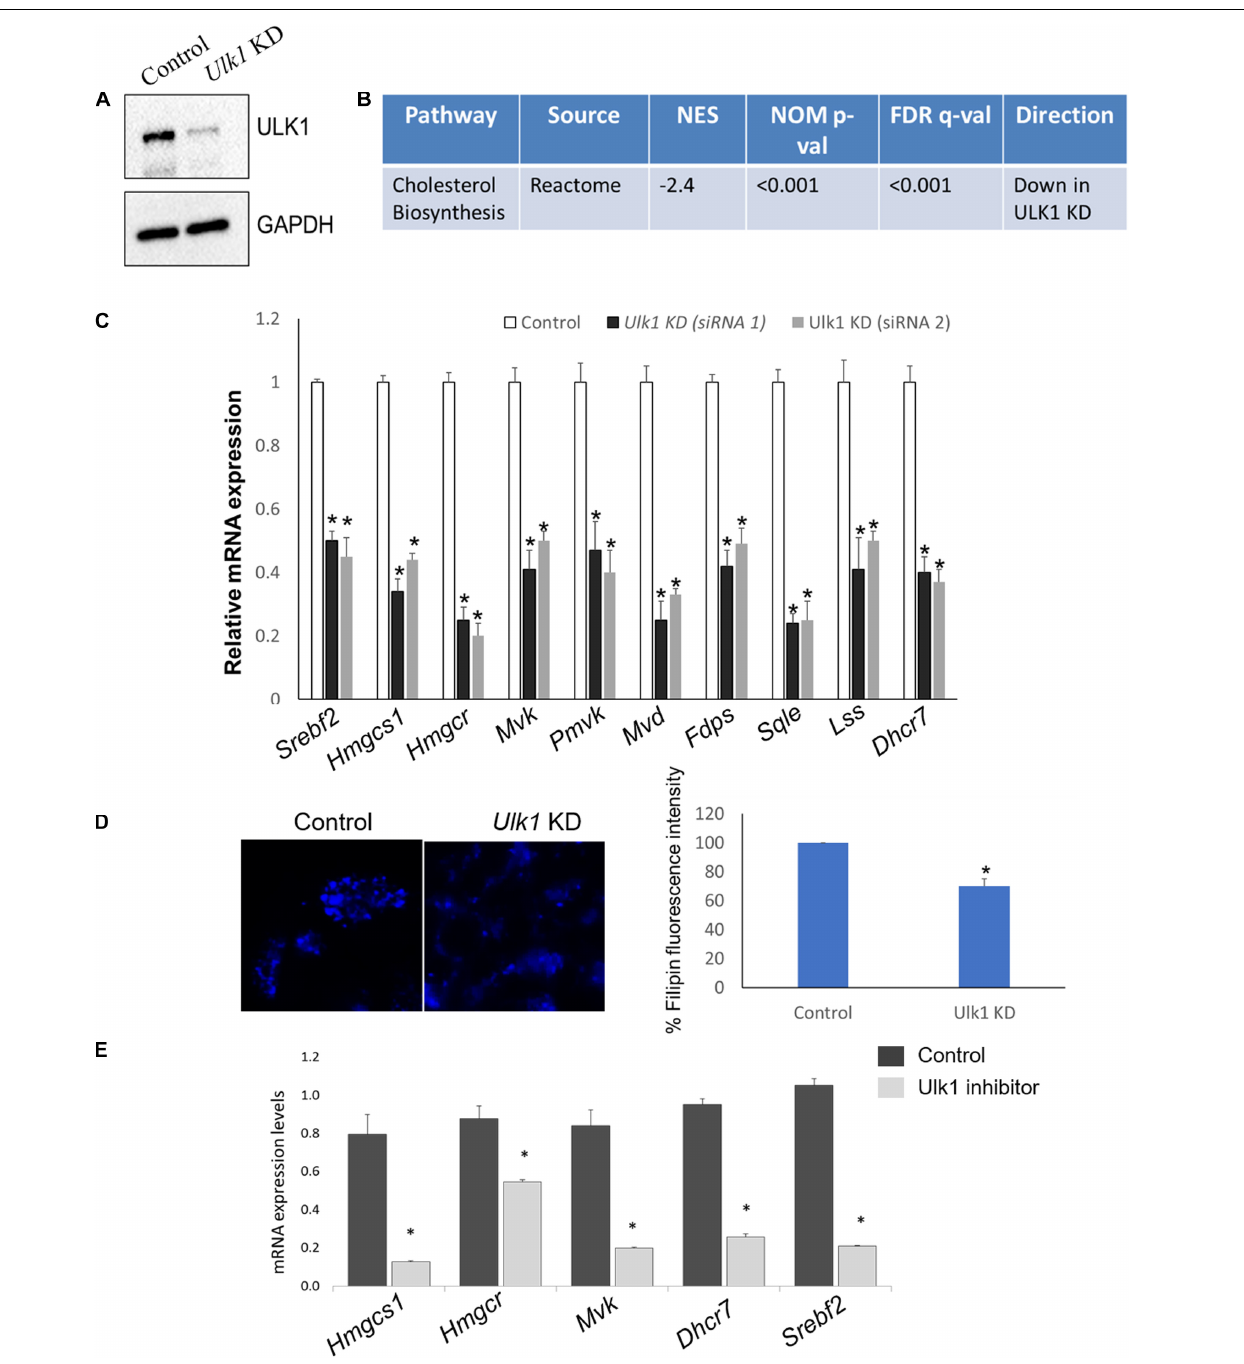
FIGURE 1 | ULK1 regulates mevalonate/cholesterol biosynthesis pathway gene expression in mouse hepatocyte AML12 cells. (A) Representative immunoblot showing knockdown (KD) efficiency of ULK1 in AML12 cells treated with ± Ulk1 siRNA (Thermo Fisher Scientific, s75753 siRNA #1; 10 nM/72 h) or a negative siRNA (denoted as Control). (B) Microarray derived transcriptomic pathway analysis in AML12 cells and mouse liver upon Ulk1 KD as described above. (C) qRT-PCR validation of mevalonate/cholesterol biosynthesis pathway genes ± Ulk1 siRNA’s 1 (Thermo Fisher Scientific, s75753 siRNA #1) and 2 (Thermo Fisher Scientific, s75751 siRNA #2) at 10 nM concentration for 72 h in AML12 cells. Values are means ± SD ( n = 4), * p < 0.05. (D) Filipin staining and quantitation showing intracellular cholesterol levels in AML12 cells treated with ± Ulk1 siRNA (Thermo Fisher Scientific, s75753 siRNA #1; 10 nM/72 h) or a negative siRNA (denoted as Control). AML12 cells upon Ulk1 KD (10 nM/72 h) were washed with PBS, fixed, and stained with filipin. All photographs were taken with the same exposure time and 20 × magnification. (E) qRT-PCR validation of cholesterol biosynthesis genes enriched in the pathway analysis treated with SBI-0206965 (ULK1 inhibitor) at a dose of 10 uM for 48 h in AML12 cells. Values are means ± SD ( n = 3, ∗ p < 0.05).